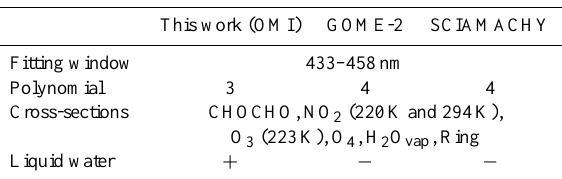
Figure 8. Distribution of CHOCHO SCs over a clean equatorial ocean region (5 ◦ S–5 ◦ N, 160–200 ◦ E) for August 2007. Table 3. CHOCHO retrieval settings for the instrument intercom- parison.